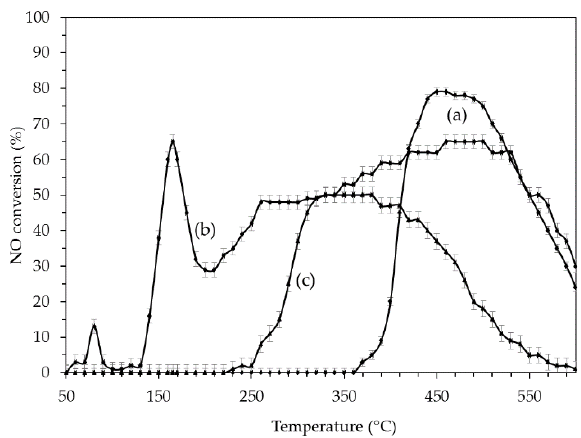
Figure 7. C 3 H 8 –SCR–NOx from ( a ) 2Ag/AW catalyst in the absence of H 2 ; ( b ) 2Ag/AW catalyst in the presence of H 2 ; ( c ) 0.4Pt/AW catalyst in the presence of H 2 . Inlet gas composition: 500 ppm NO, 625 ppm C 3 H 8 , 200 ppm CO, 660 ppm H 2 , 2 vol.% O 2 , N 2 balance; GHSV = 128,000 h − 1 .